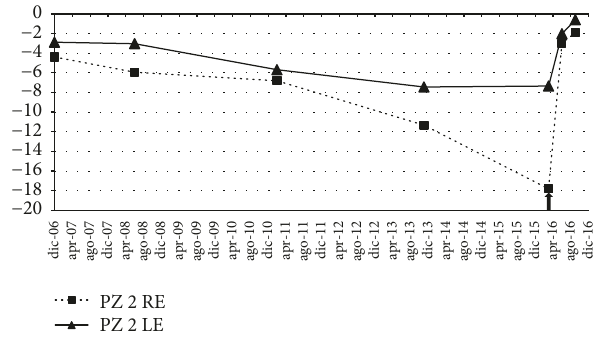
Figure 3: Ten-yeartrendof themean deviation(MD),from Decem- ber 2006 to September 2016. The arrow indicates the beginning of treatment with CBS eye drop. RE: right eye; LE: left eye.